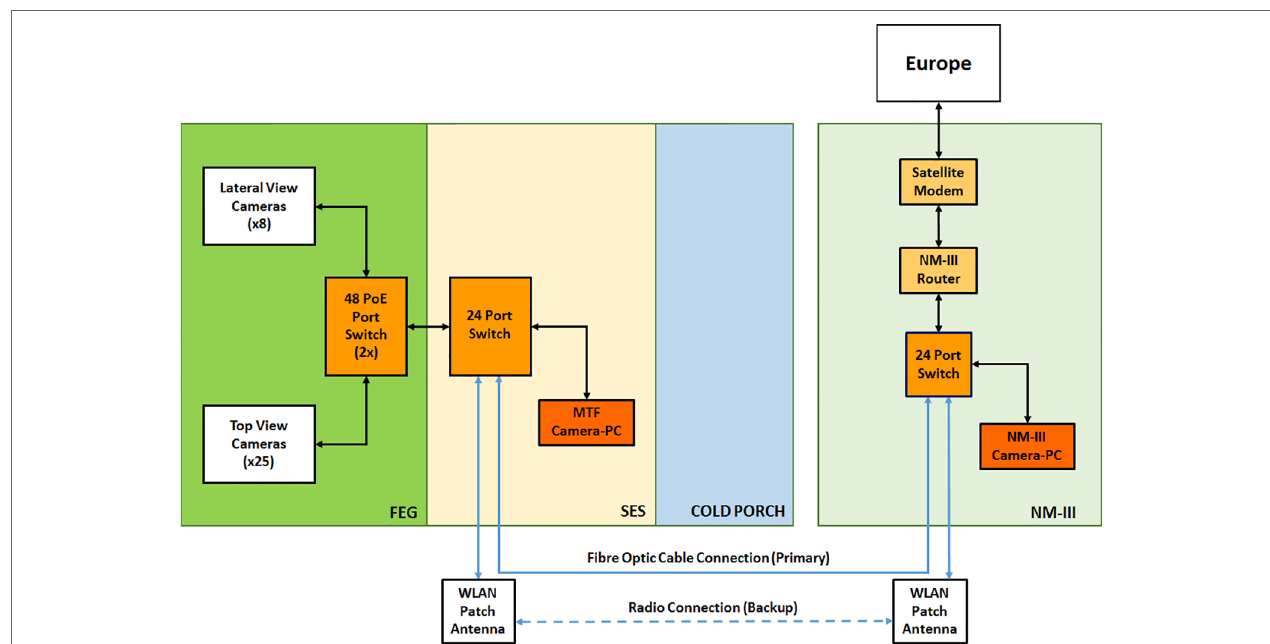
FIGUrE 7 | HD color camera network layout, including communication and storage systems.